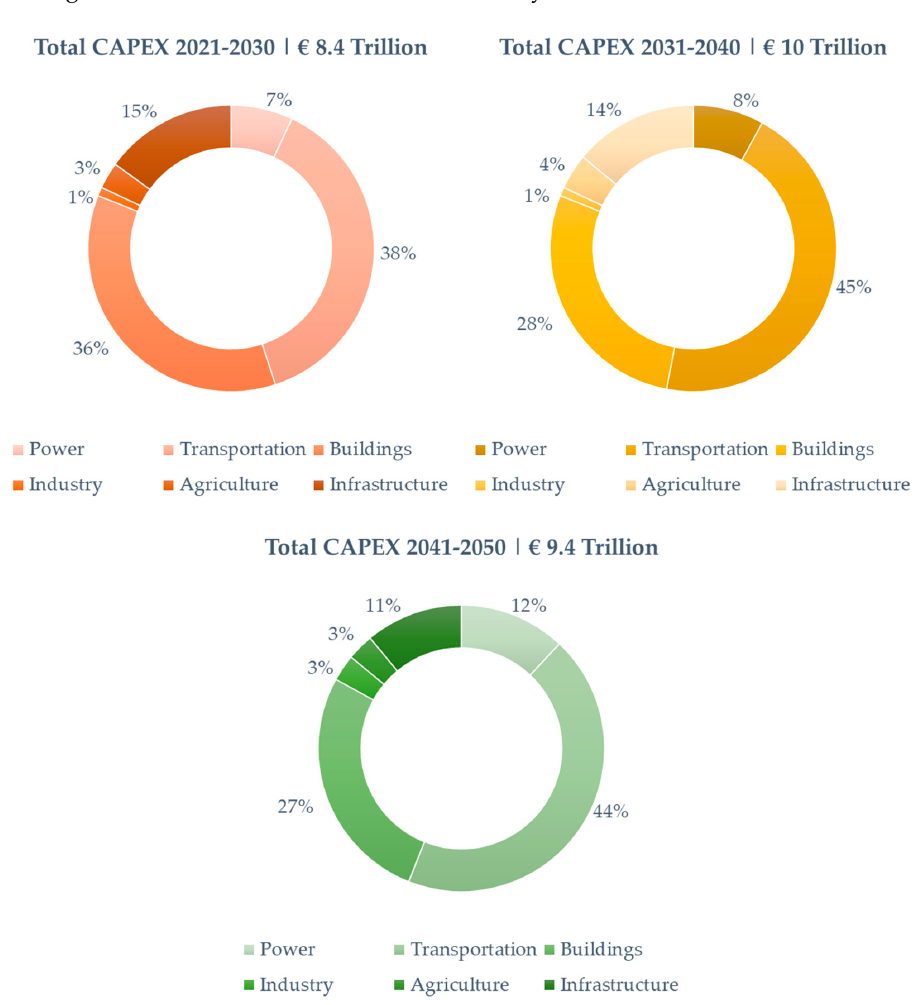
Figure 8. Total CAPEX in EU-27, broken down by sector per decade, for the period 2021 to 2050 (created using data from [137]).